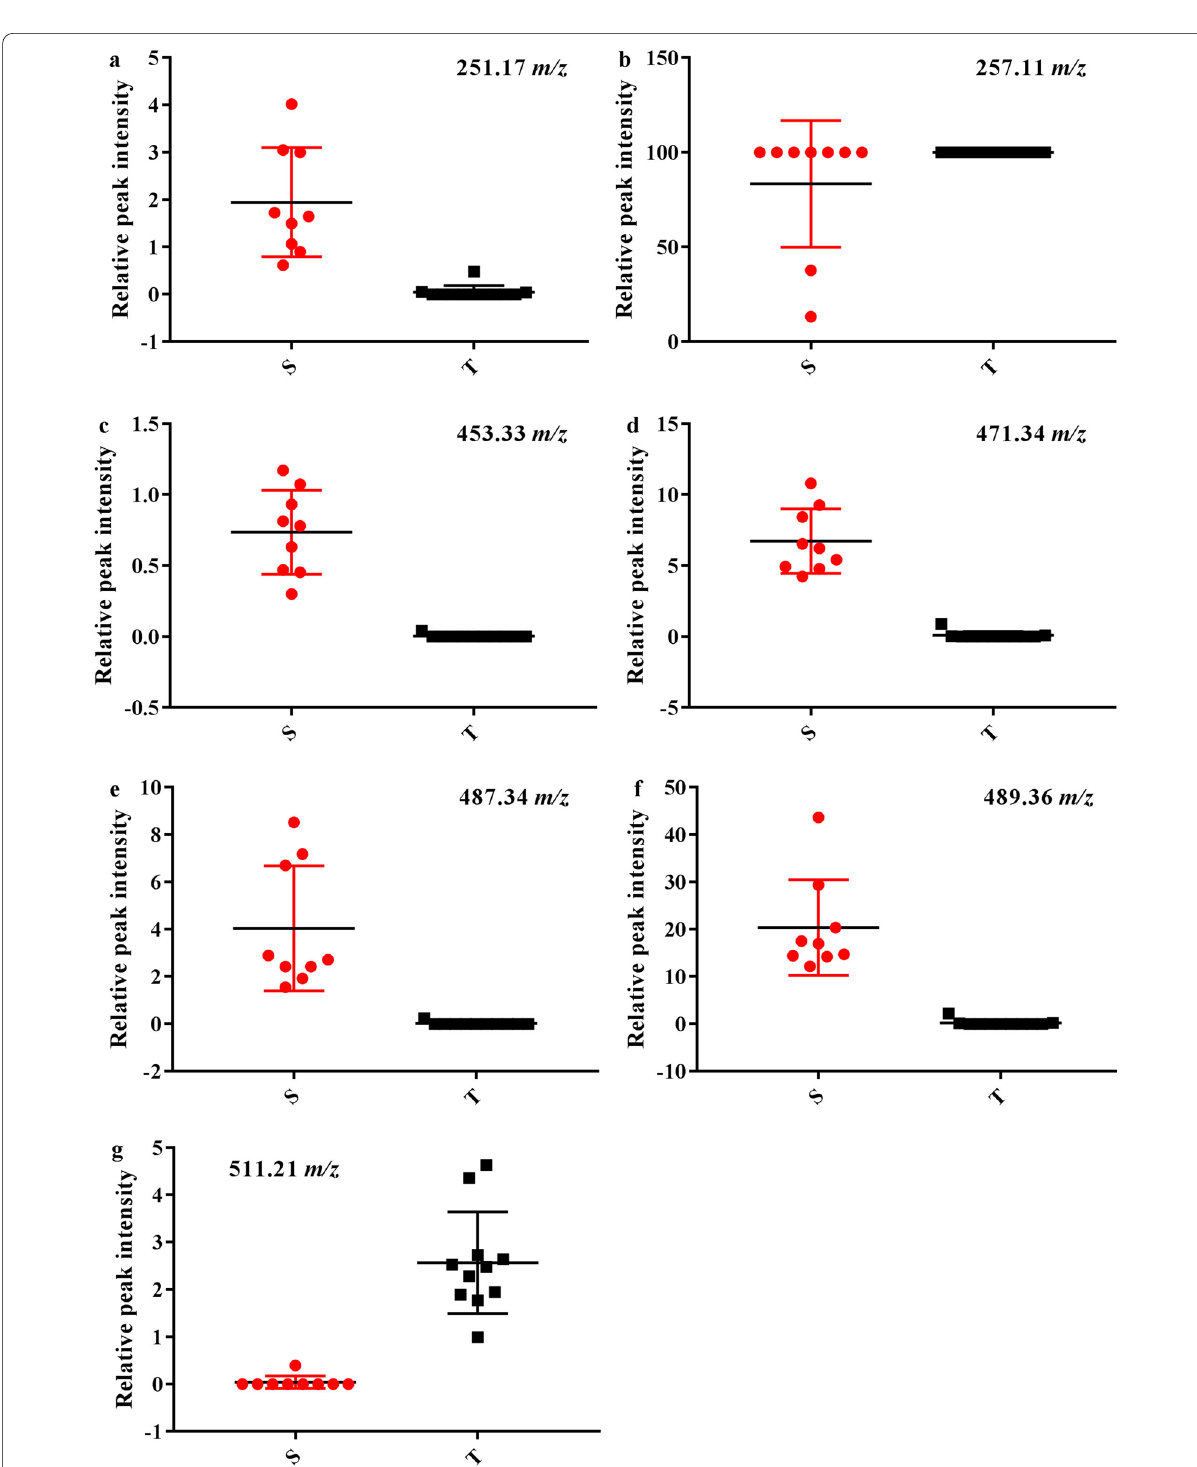
Fig. 7 Relative peak intensities of seven ions from the DART–MS coupled with SNF. 251.17 m /z ( a ), 257.11 m /z ( b ), 453.33 m /z ( c ), 471.34 m /z ( d ), 487.34 m /z ( e ), 489.36 m /z ( f ), 511.21 m /z ( g ). Pterocarpus santalinus ( S ), Pterocarpus tinctorius ( T